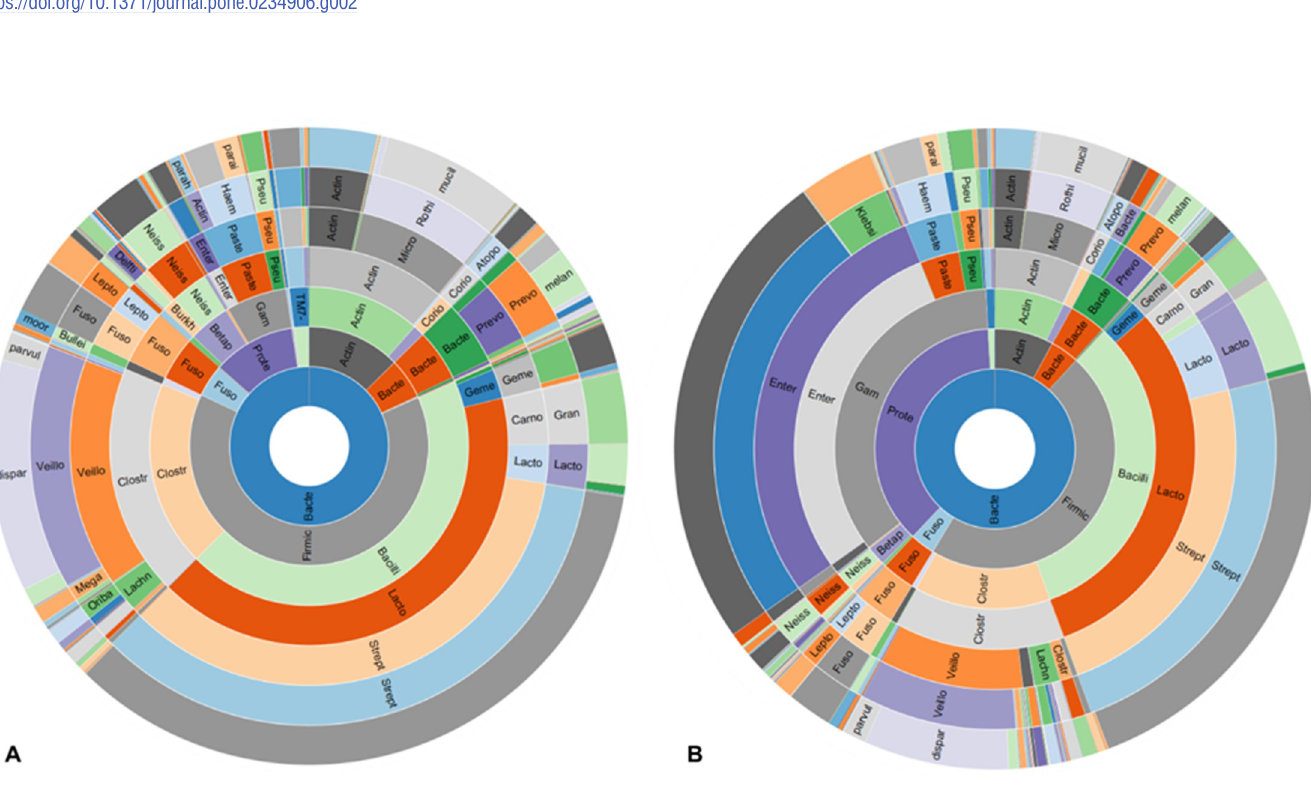
PLOS ONE | https://doi.org/10.1371/journal.pone.0234906 July 9,